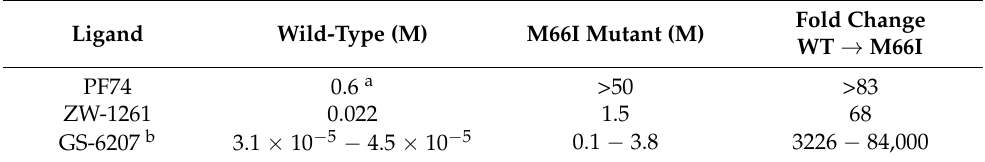
Figure 1. ( A ): Crystal structure of PF74 (purple) bound at the dimeric interface of a CA hexamer. ( B ): Crystal structure of GS-6207 (black), ZW-1261 (green), and PF74 (purple) bound at the dimeric interface of two CA monomers. ( C ): The binding site of the ligands at the NTD − CTD interface in a CA dimer. ( D ): Chemical structures of GS-6207, ZW-1261, and PF74. Table 1. EC 50 measurements of PF74, ZW-1261, and GS-6207 against wild-type and M66I mutant viruses.